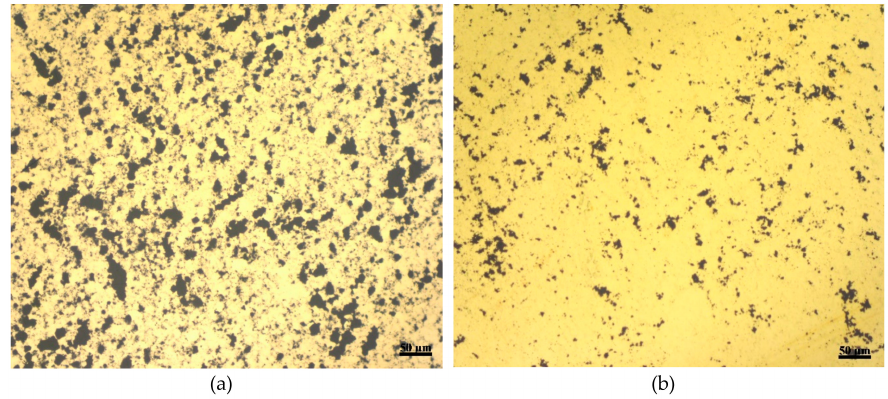
Figure 9. Two microscopic images for porous gold film with film thickness of: ( a ) ~800 nm ( b ) ~1400 nm where the concentration of the GO dispersion is 4 mg / mL and the etching time for the gold film is 30